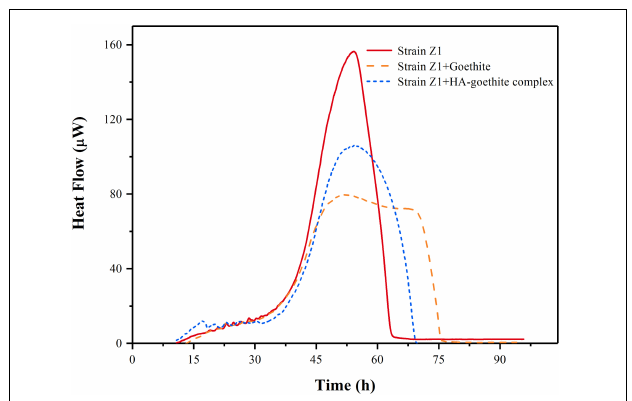
FIGURE 4 | Calorimetric signal versus time for Pseudomonas sp. Z1 metabolism in the presence of goethite and HA-goethite complex.